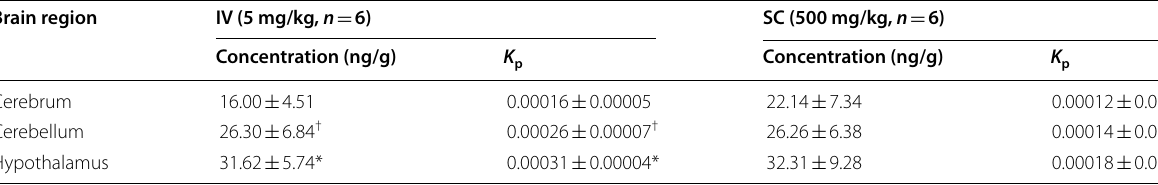
Table 6 Distribution of liraglutide in the different regions of the brain following intravenous (IV, 5 mg/kg) and subcutaneous (SC, 500 mg/kg) injections in rats